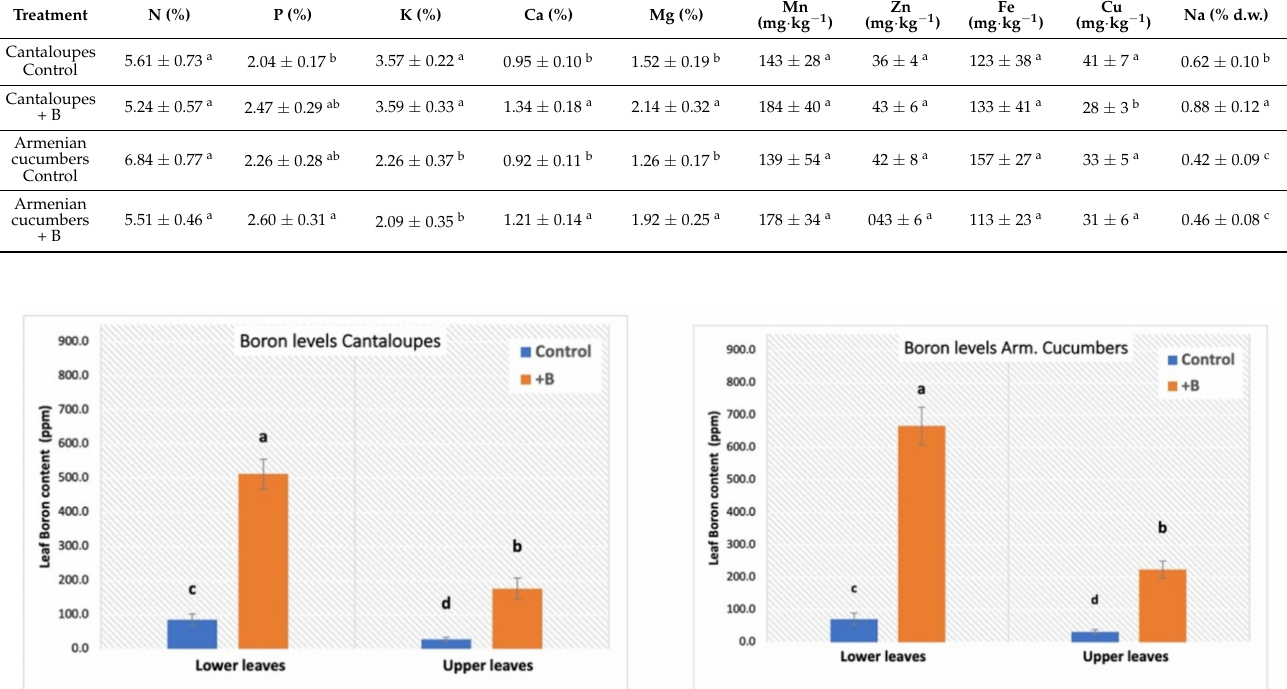
Table 3. Effect of the oversupply of B (by using H 3 BO 3 ) on foliar macro- and micro-nutrient content of cantaloupes ( C. melo var. Cantalupensis cv. Retato Degli Ortolani) and Armenian cucumbers ( C. melo var. flexuosus cv. Abruzzese Tortarello). Growth period lasted 35 d, where no visible B toxicity symptoms were apparent (Figure 1). Measurements were conducted on combined young and mature leaves. Means followed by different letters indicate significant differences ( p = 0.05; per cultivar comparison in columns).